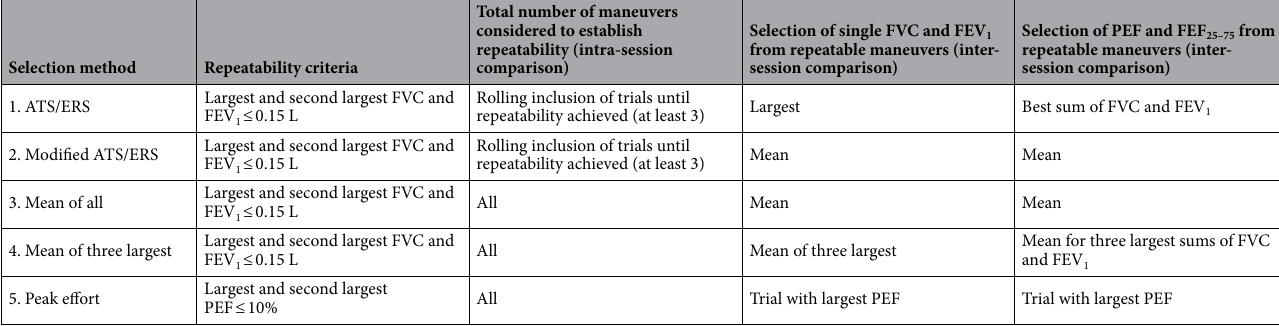
Table 1. Selection methods for forced vital capacity (FVC) and forced expiratory volume in one second